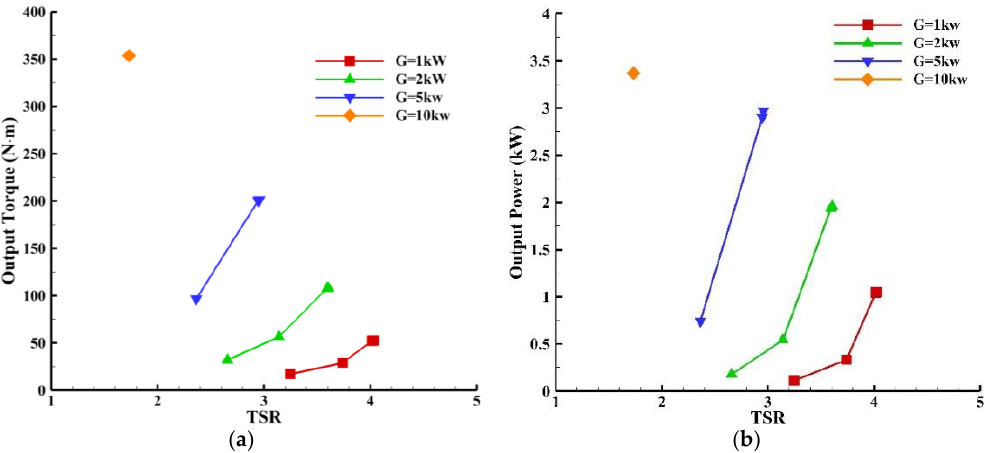
Figure 10. Operating performance of the VAT rotor: ( a ) Output Torque; ( b ) Output Power.